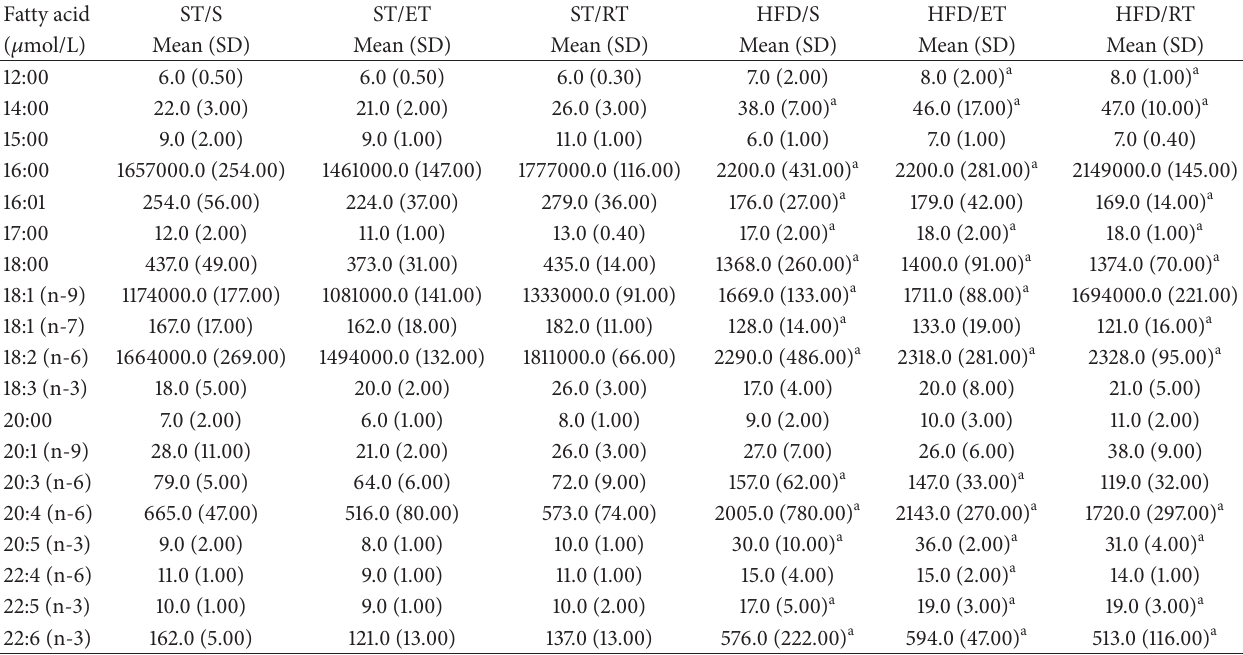
Table 2: Effects of exercise on the plasma total fatty acid profiles of standard diet or HFD mice.